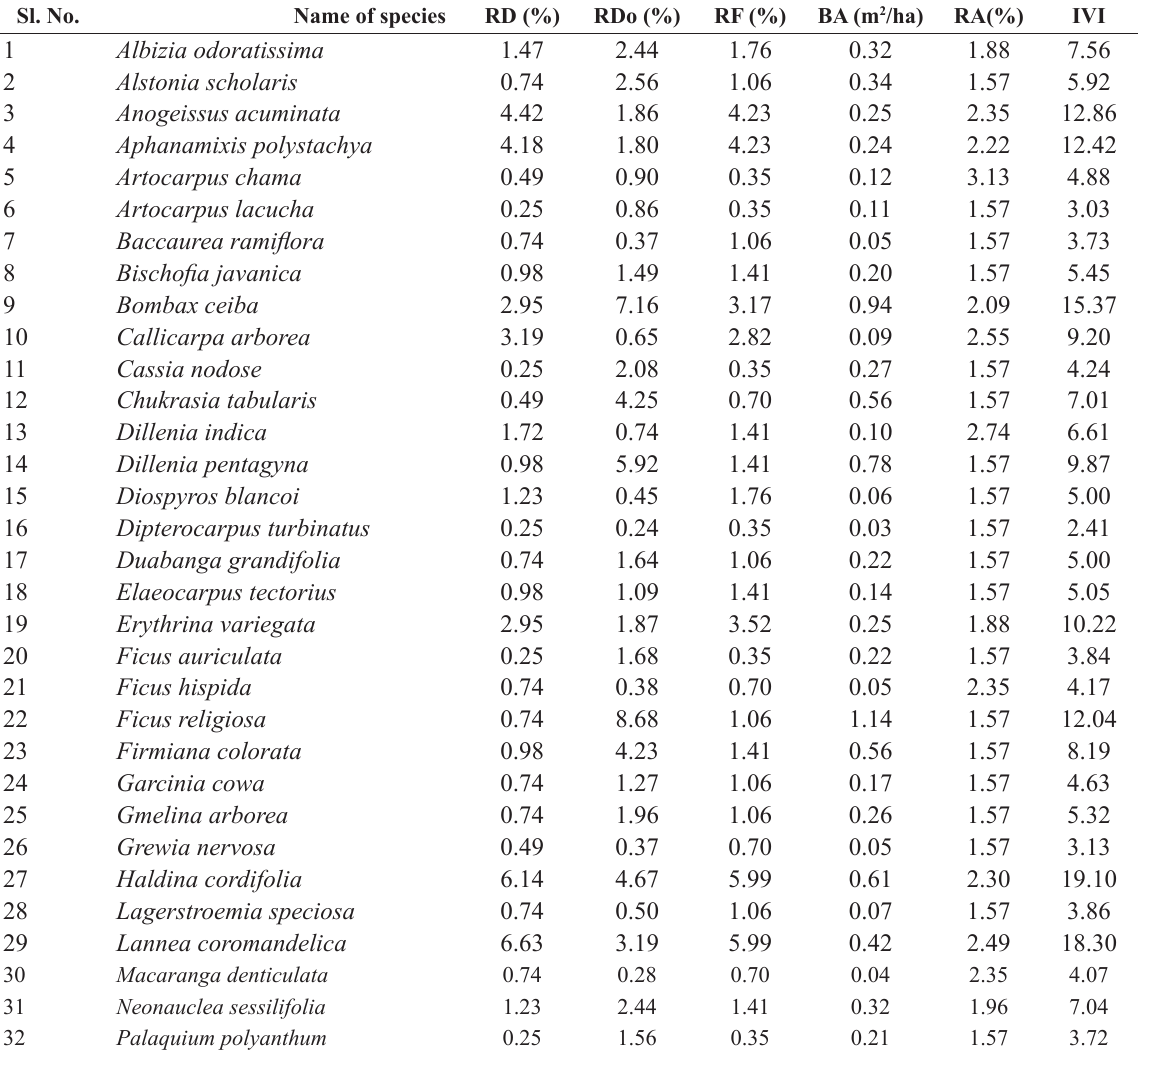
Table 4: Quantitative structure of the tree species of Rampahar Forest Reserve. [here, RD = Relative Density, RDo = Relative Dominance, BA = Basal Area, RA = Relative Abundance, IVI = Importance Value Index ] Sl.